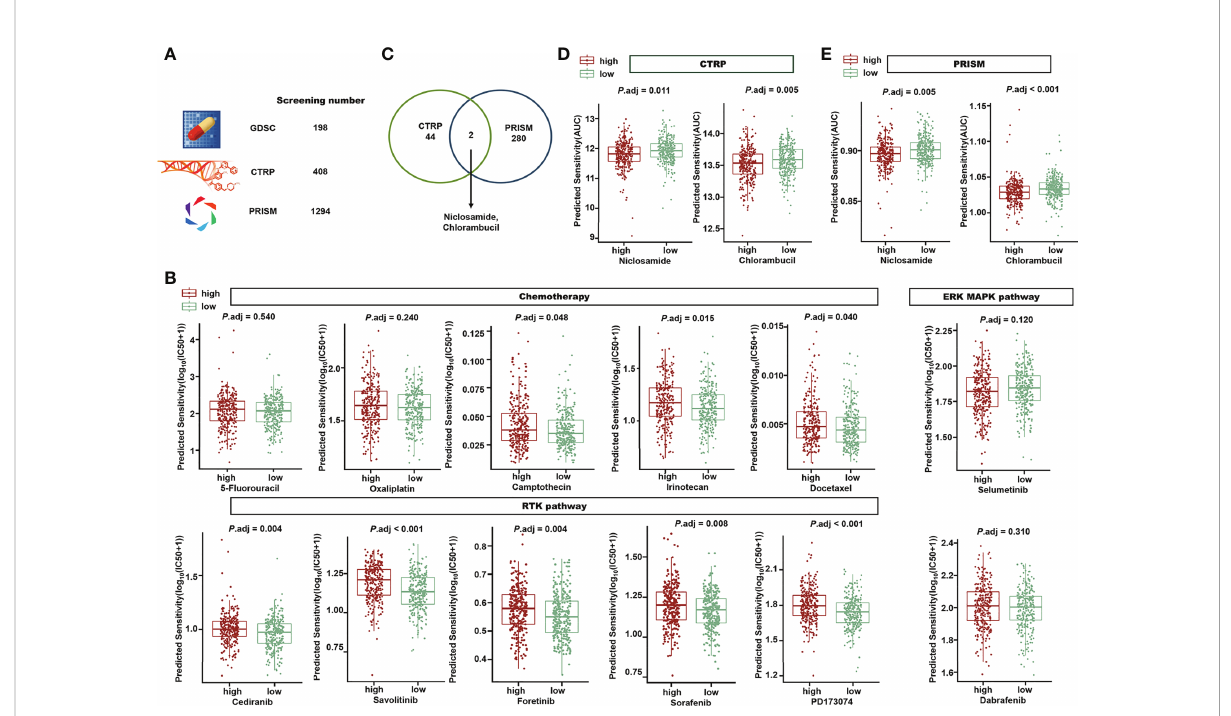
FIGURE 11 Exploration of the risk signature and drug sensitivity. (A) A total of 1900 compounds from GDSC, CTRP, and PRISM were screened to investigate promising drugs for clinical treatment. (B) In the high- or low-risk groups, different predicted IC50 values of drugs in chemotherapy, the RTK pathway, and the ERK/MAPK pathway are displayed. (C) Venn diagram showing the two candidate compounds between CTRP and PRISM. Niclosamide and chlorambucil are the two compounds predicted with signi fi cantly lower AUCs in the high-risk group ( P adj< 0.05) in CTRP (D) and PRISM (E) . GDSC, Genomics of Drug Sensitivity in Cancer; CTRP, The Cancer Therapeutics Response Portal; PRISM, Pro fi ling Relative Inhibition Simultaneously in Mixtures; RTK, receptor tyrosine kinase; and ERK/MAPK, extracellular signal-regulated kinase/mitogen-activated protein